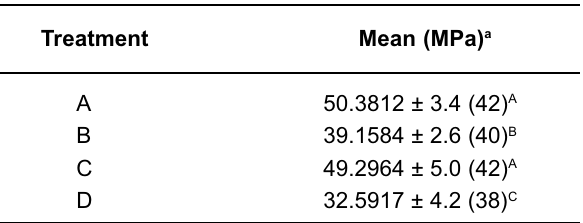
Values are expressed as means ± standard deviations. Number of tested specimens is in parenthesis. Experimental groups identified by different superscript letters are significantly different from the control group (P <